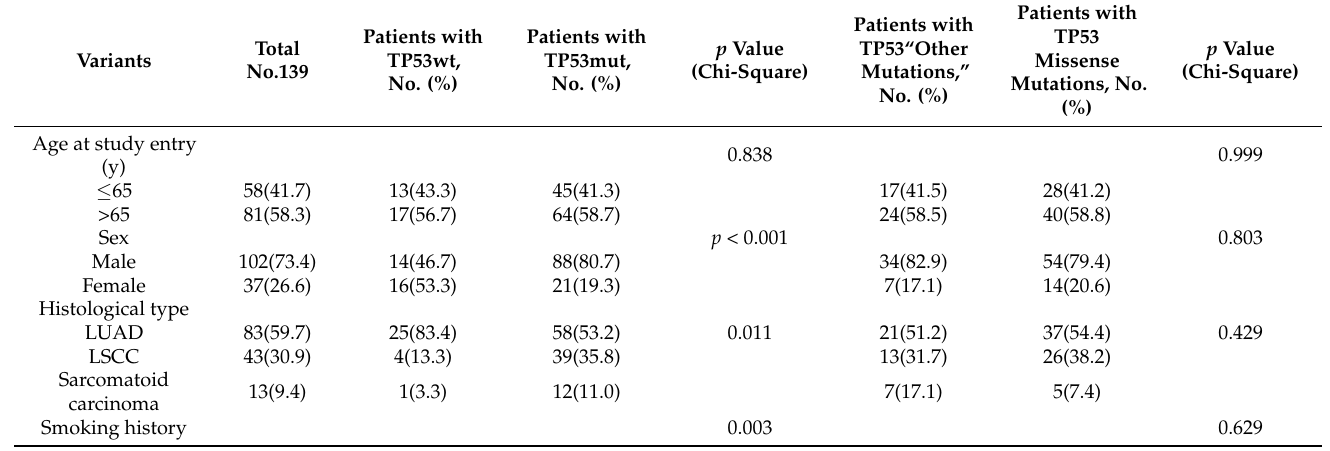
Table 1. Demographics and characteristics for patients with TP53wt and TP53mut in advanced lung